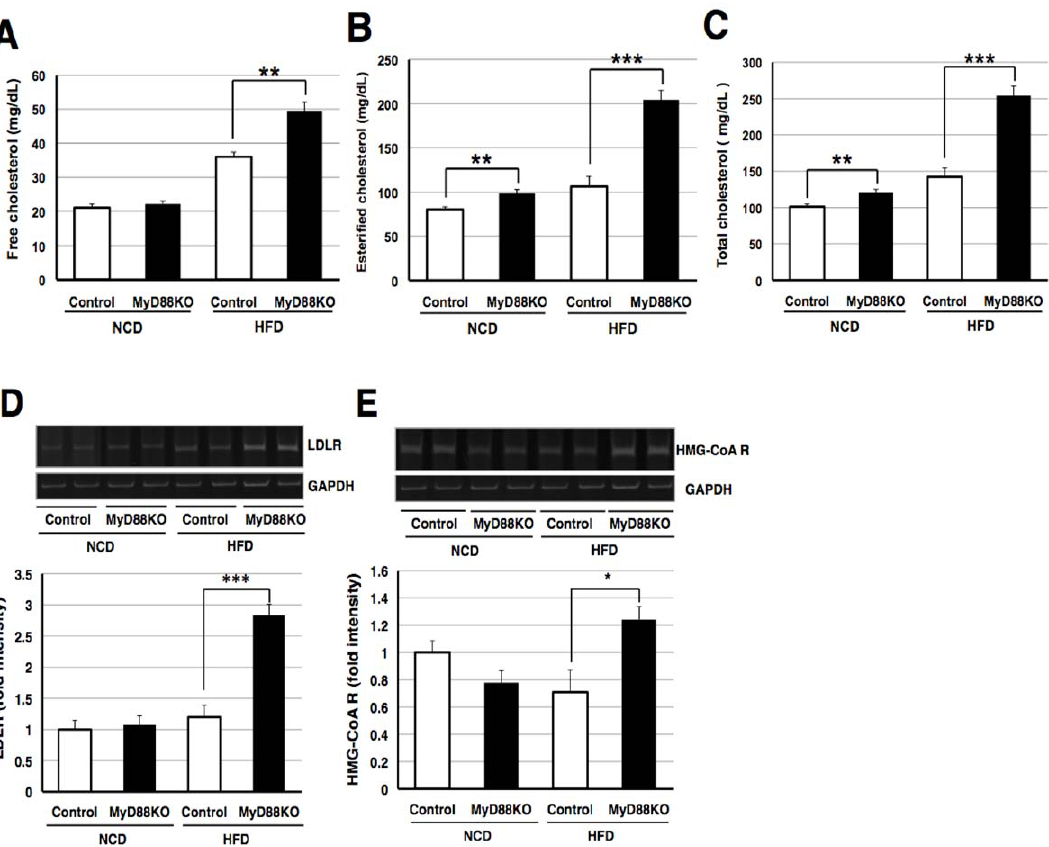
Figure 5. MyD88-deficient mice fed the HFD increases circulating level of cholesterol. ( A–C ) Serum cholesterol concentrations were measured at the age of 18 weeks. ( A ) Free cholesterol, ( B ) esterified cholesterol and ( C ) total cholesterol levels. Each genotype of mice was fed the NCD (n=8) or HFD (n=6–7). ** p , 0.01, *** p , 0.001 ( DE ) mRNA levels of LDLR and HMG-CoA reductase (HMG-CoA R) were measured in liver samples at the age of 18 weeks. (n=6–8) * p , 0.05, *** p , 0.001.